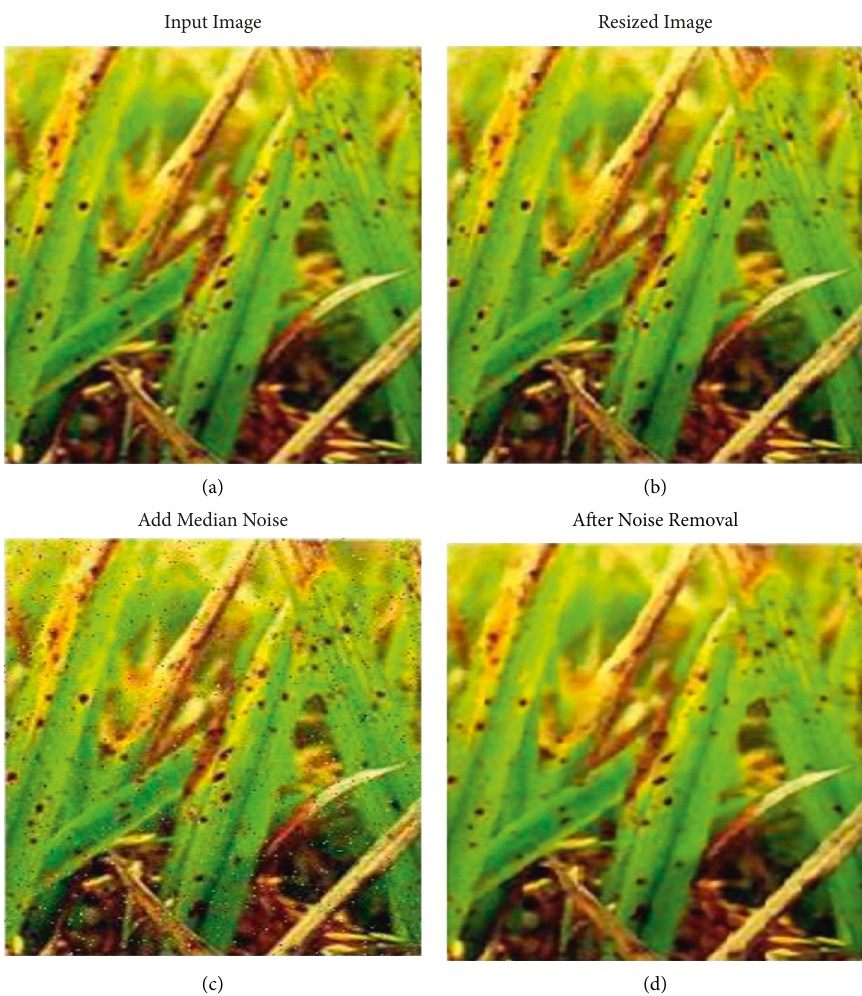
Figure 9: Results of median noise. (a) Input image of rice blast. (b) Resized image. (c) Denoised image. (d) Image obtained after denoised by median